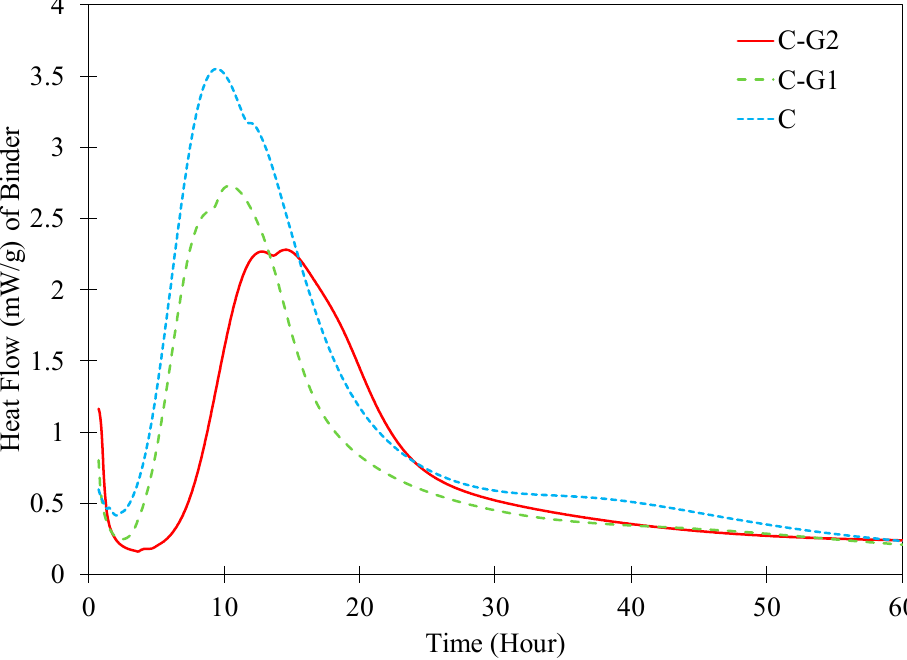
Figure 3. Heat flow of C, C-G1, and C-G2 pastes.